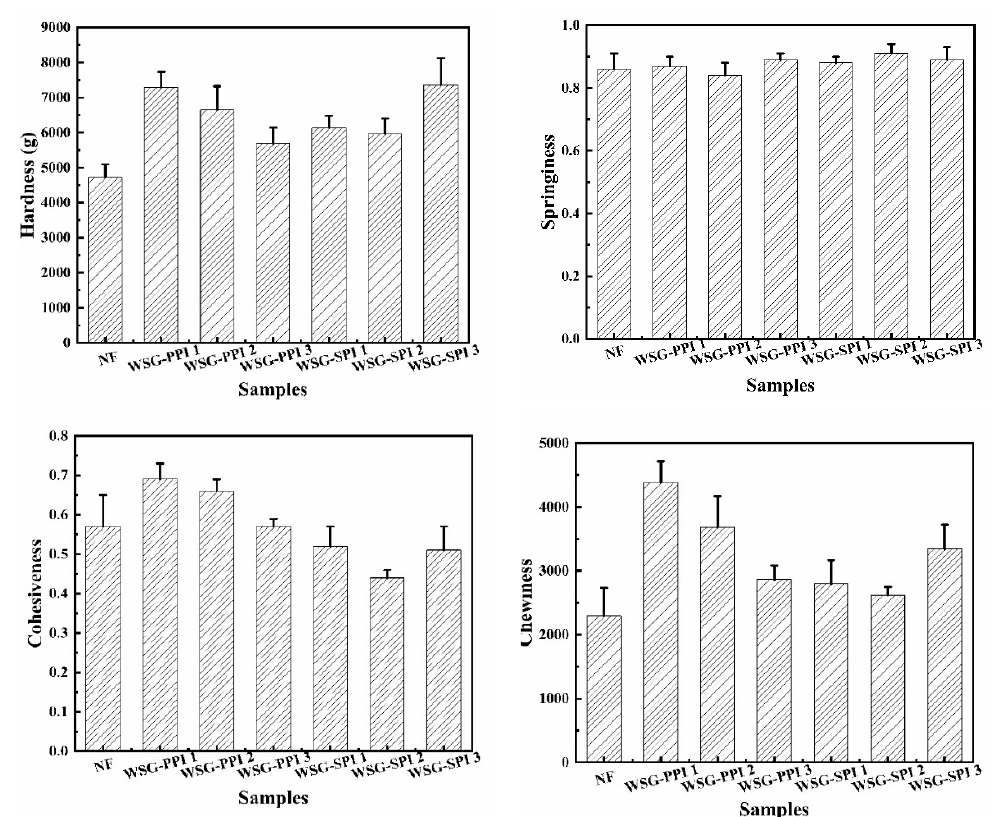
Figure 8. The texture of low-fat sausages.